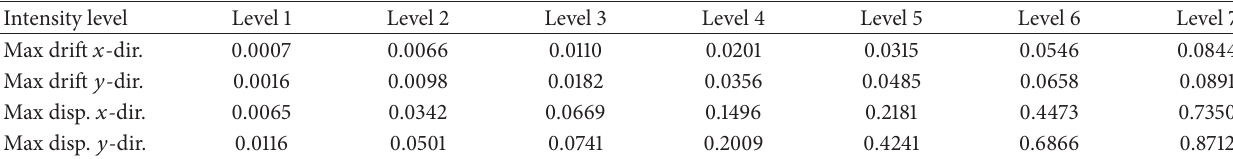
Table 3: Response of the structure for different intensity